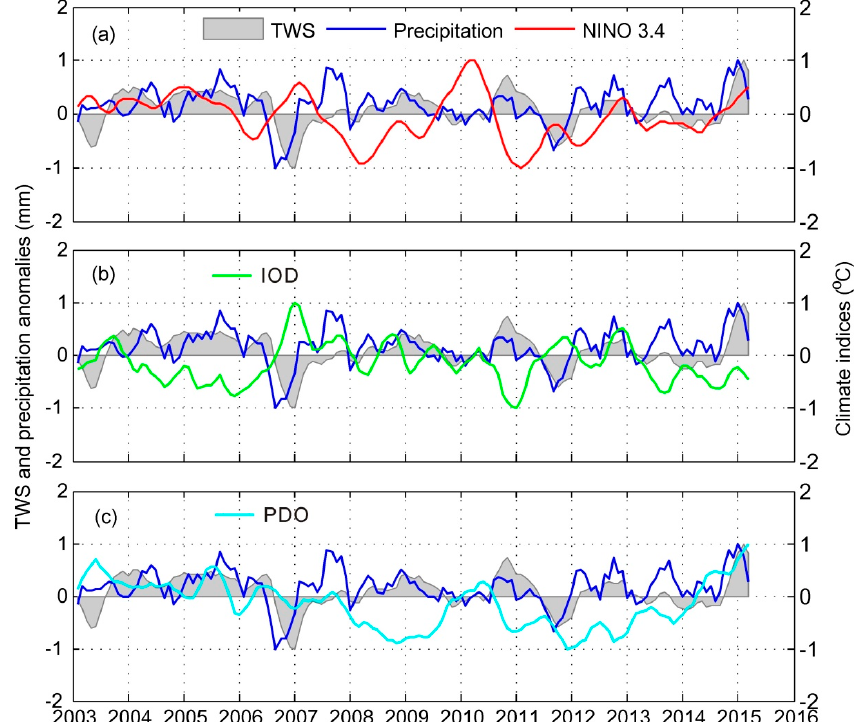
Figure 7. Normalized and five-month mean time series of non-seasonal Sichuan Basin TWS anomalies, precipitation, and indices of ( a ) NINO 3.4; ( b ) IOD; and ( c ) PDO. Table 2. Correlation coefficients between TWS/precipitation and IOD/ENSO over the Sichuan Basin. The insignificant values are marked in bold. Correlations are computed at 95% level of